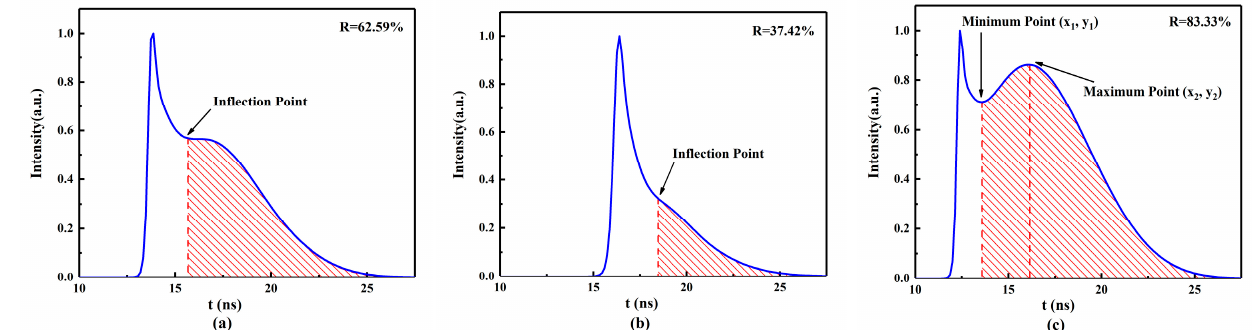
Figure 1. Three temporal waveforms: ( a ) ideal temporal step waveform; ( b ) temporal waveform with negligible trailing-edge energy; ( c ) temporal waveform with excessive trailing-edge